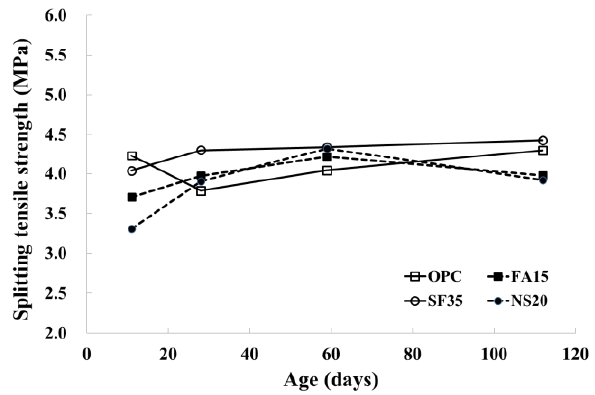
Figure 4. Splitting tensile strength vs. age.